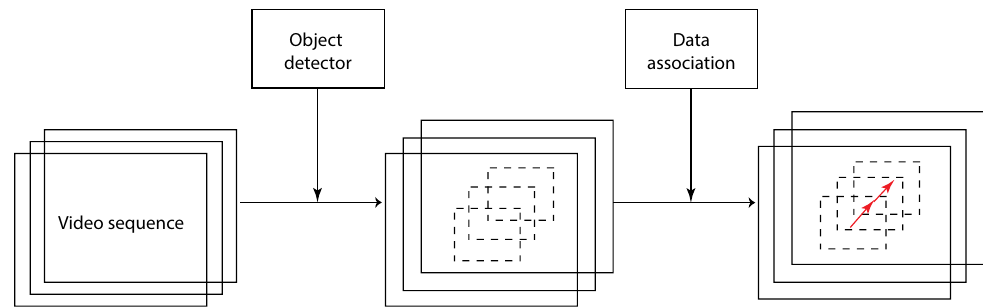
Figure 12. High-level illustration of tracking-by-detection framework. Data association is the process of associating uncertain detections to known